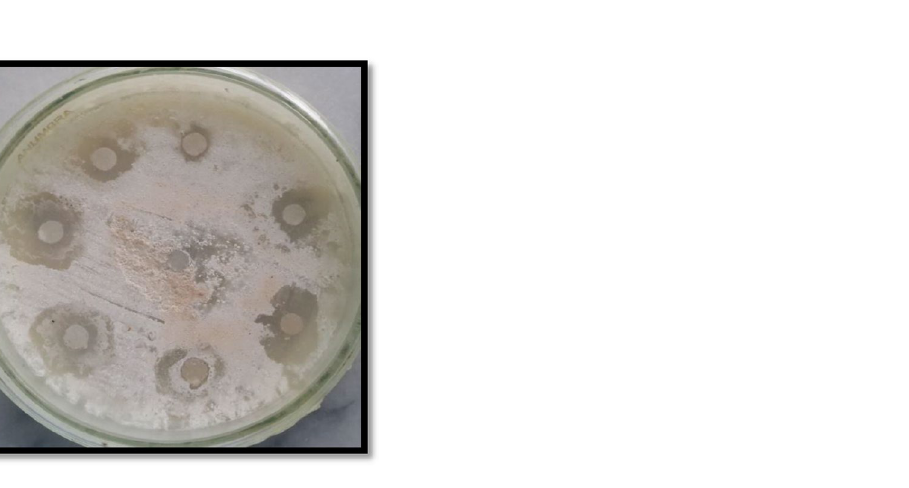
Figure 7. Protein kinase inhibition activity of F. cretica crude extracts and its ZnO nanoparticles. α-Amylase inhibition